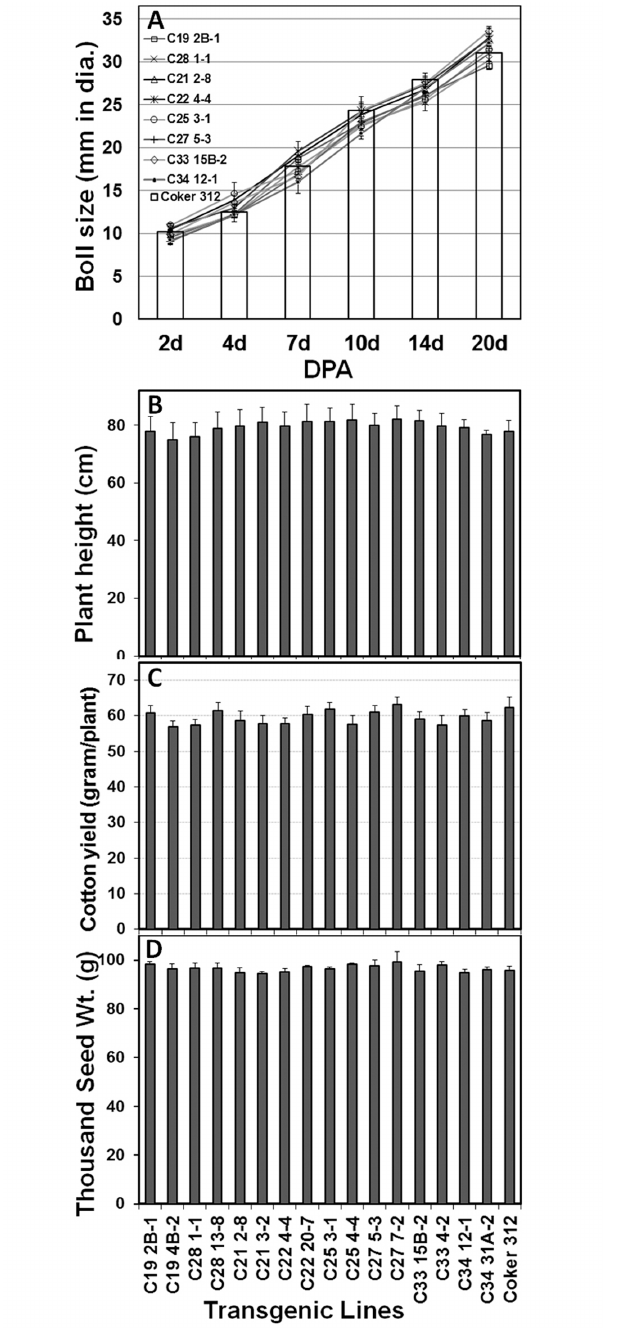
Fig 3. Comparisons of agronomic traits of T 4 CFSP::GUS transgenic lines with those of Coker 312 wildtype plants under normal conditions. (A) cotton boll size, Coker 312: open column, transgenic lines: lines. (B) Plant height. (C) Cotton yield per plant. (D) Delinted 1000-seed